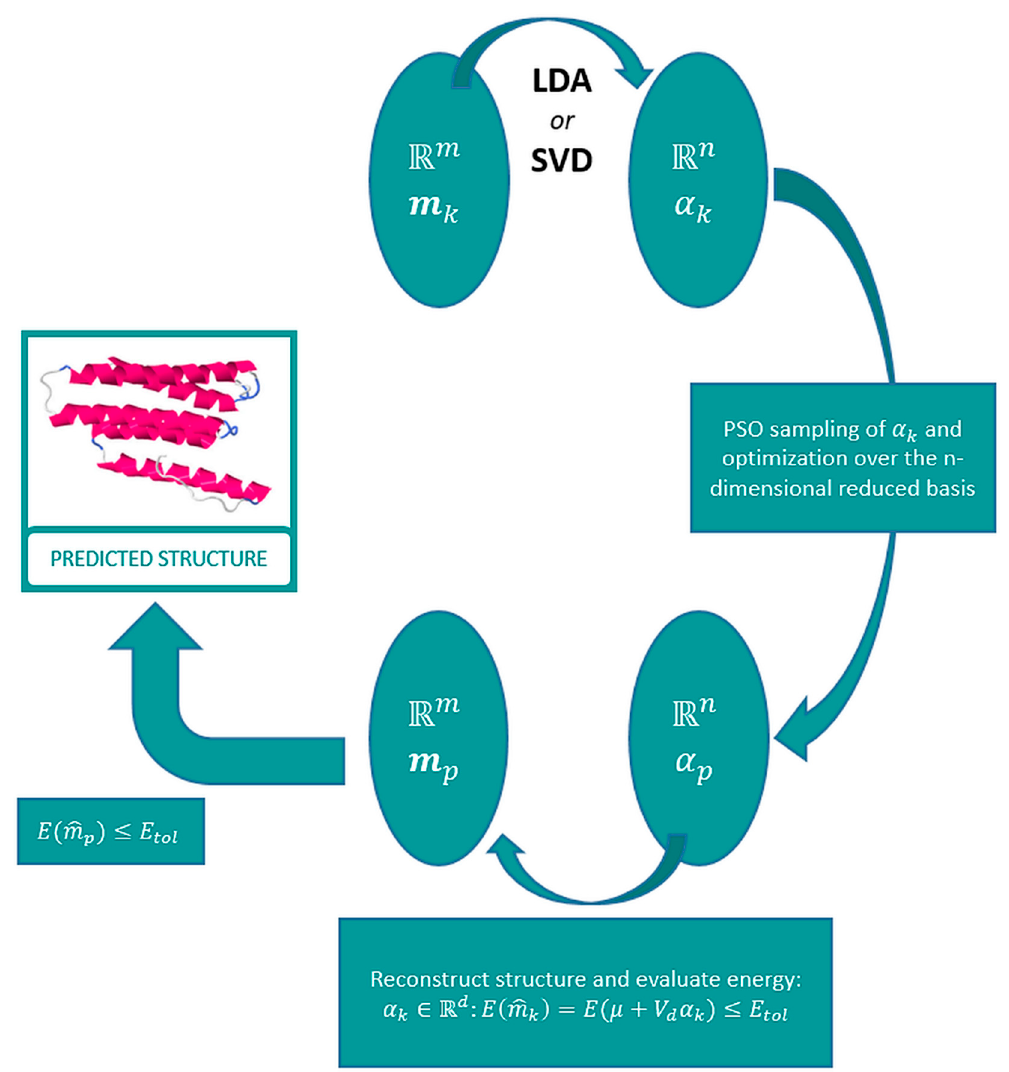
Figure 1. Linear discriminant analysis (LDA)–singular value decomposition (SVD) algorithm flowchart.